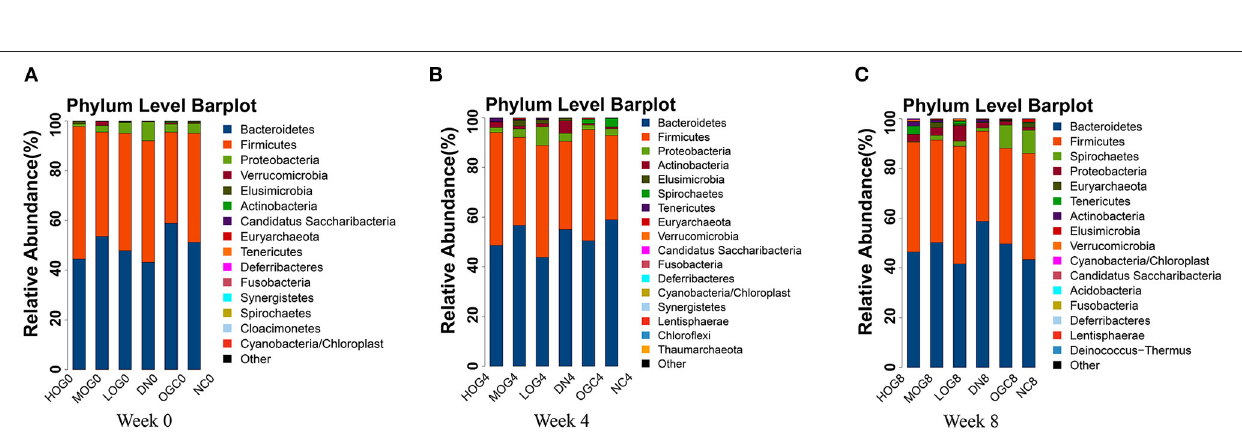
Frontiers in Nutrition |